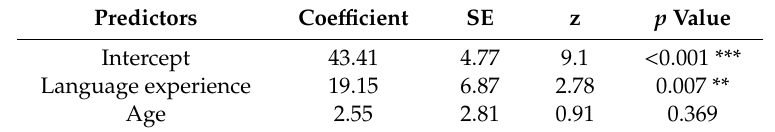
Table 7. Summary of logit mixed e ff ects model: Composite accuracy in the two-back task. Predictors